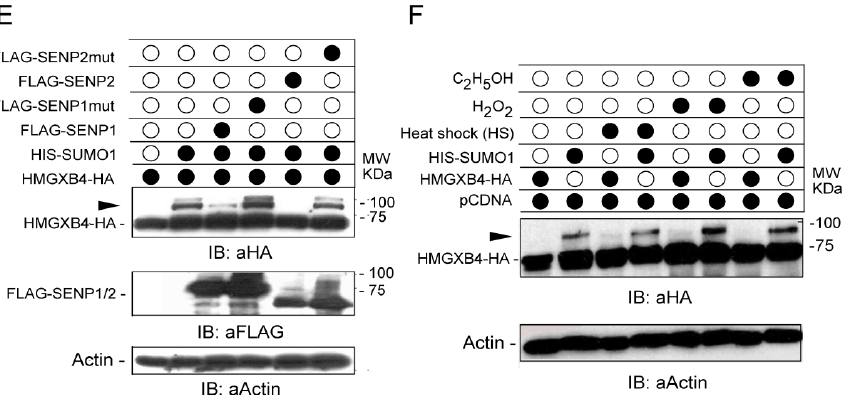
Figure 1. HMGXB4 is regulated by SUMOylation. ( A ) (Left panel) HMGXB4 gets SUMOylated in the presence of SUMO1 (immunoblots). HeLa cells were co-transfected with expression constructs of the tagged versions of the candidate proteins, HMGXB4-HA and HIS-SUMO1. Whole-cell lysates were immunoblotted. A slower migrating band, potentially corresponding to the SUMOylated version of HMGXB4, is marked by a black triangle (Right panel). The membrane is striped and rehybridized using an antibody against SUMO1. ( B ) All three SUMO variants (e.g., 1, 2 and 3) can SUMOylate HMGXB4. HeLa cells were co-transfected with expression plasmids encoding HMGXB4- HA, HIS-SUMO1, 2, 3 or a mutated version of FLAG–SUMO1 ∆ GG, defective in conjugation. The SUMOylated HMGXB4 versions are expected to appear as slower migrating bands (black triangles) on the immunoblot, using HA-specific antibodies in whole-cell lysates. Importantly, no shifted bands were detectable when HeLa cells were transfected with the mutated version of SUMO1mut, lacking the diglycine C-terminal motif required for its conjugation to substrates SUMO1- ∆ GG [36]. ( C ) K317R/K320R dual mutations abolish the post-translational modification and SUMOylation of HMGXB4. HeLa cells were co-transfected with expression plasmids encoding HMGXB4-HA, HMGXB4 K317R/K320R -HA (referred to as HMGXB4 SUMO- in the following) and His-SUMO1. The whole-cell HeLa lysates were immunoblotted with an HA-specific antibody. The SUMOylated HMGXB4 is an additional, slower migrating band (marked by a black triangle). ( D , E ) SUMOylation of HMGXB4 is reversible by SUMO-specific proteases (SENPs). HeLa cells were co-transfected with expression constructs of HMGXB4-HA, HIS-SUMO1 and SENP1, SENP2 and SENP3 or their SUMO deconjugation defective mutant versions (mut), SENP1 602S , SENP2 C547S and SENP3 C532S [32,37], respectively. Whole-cell lysates were subjected to immunoblotting with anti-HA to monitor HMGXB4 and FLAG/GFP-specific antibodies to detect the SENP proteins. The SUMOylated HMGXB4 appears as an additional and slower migrating band (marked by black triangle). ( F ) SUMOylation of HMGXB4 is stress sensitive. The in vitro SUMOylation assay was performed under various cellular stress conditions. Note that ethanol and H 2 O 2 treatments enhanced the abundance of the SUMOylated bands compared to the untreated condition. The SUMOylated HMGXB4 appears as an additional and slower migrating band (marked by black